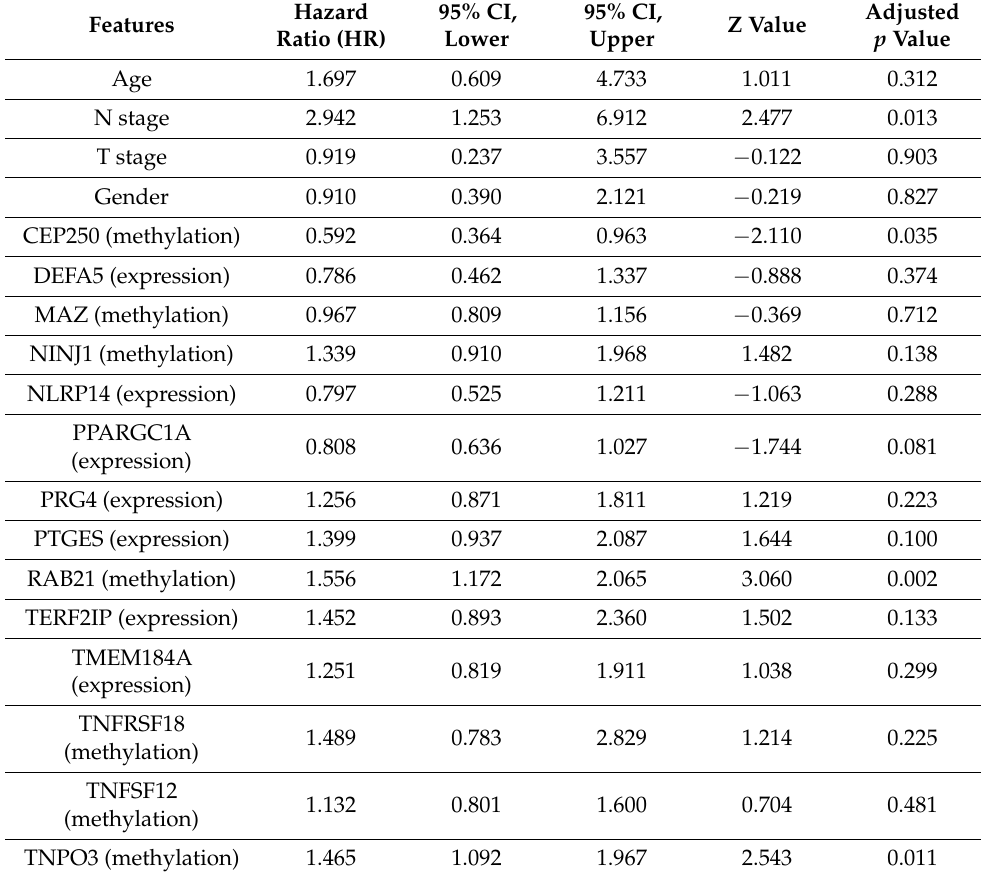
Table 3. Association analysis of the integrative model with clinical, gene expression and methylation features and overall survival. Analysis was performed with multivariate Cox proportional hazard regression. CEP250, centrosomal protein 250; DEFA5, defensin alpha 5; MAZ, MYC-associated zinc finger protein; NINJ, nerve injury-induced protein 1; NLRP14 (expression), NLR family pyrin domain-containing 14; PPARGC1A, peroxisome proliferator-activated receptor γ coactivator 1 alpha; PRG4, proteoglycan 4; PTGES, prostaglandin E synthase; RAB21, member of the RAS oncogene family; TERF2IP, TERF2-interacting protein; TMEM184A, transmembrane protein 184A; TNFRSF18, TNF receptor superfamily member 18; TNFSF12 TNF superfamily member 12; TNPO3, transportin 3. Hazard 95% CI, Features Ratio (HR)